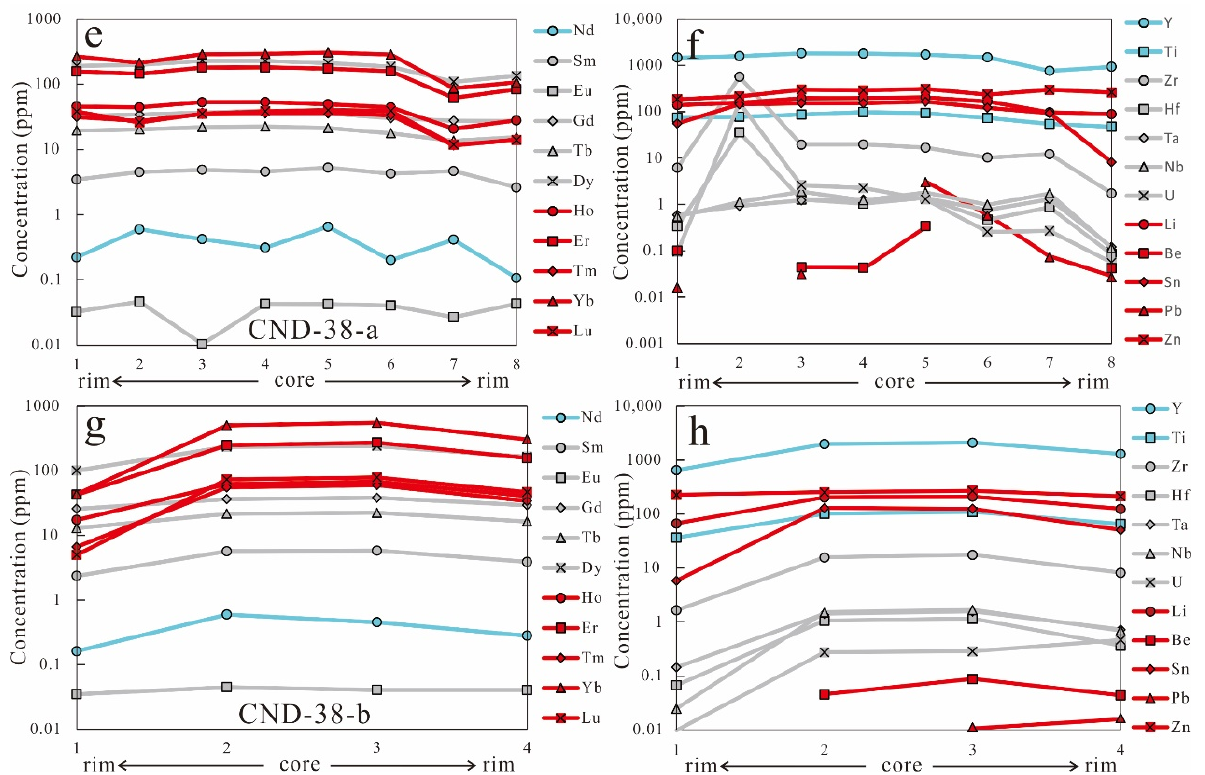
Minerals 2022 , 12 , x Figure 7. ( a – h ) Rare earth element and trace element core – rim profiles of garnet from the pegma- Figure 7. ( a – h ) Rare earth element and trace element core–rim profiles of garnet from the pegmatite. tite.